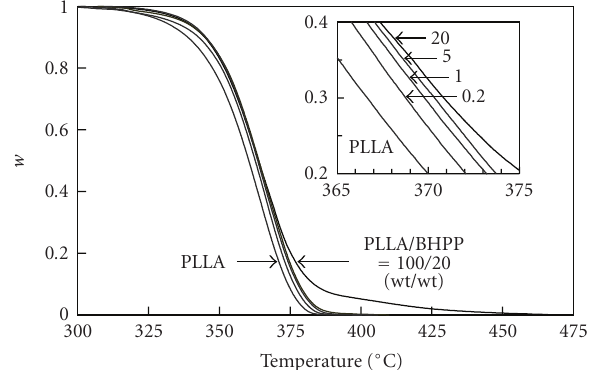
Figure 8: Thermogravimetric analysis of PLLA, PLLA/BHPP (0.2, 1.0, 5, and 20 wt%). ϕ = 9 ◦ Cmin − 1